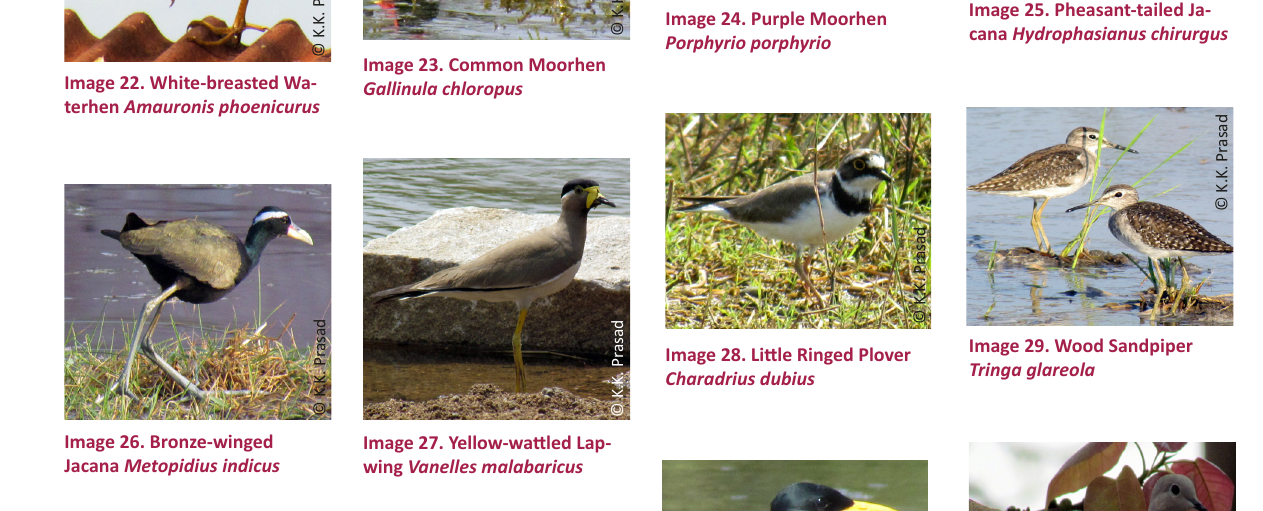
Image 25. Pheasant-tailed Ja- cana Hydrophasianus chirurgus